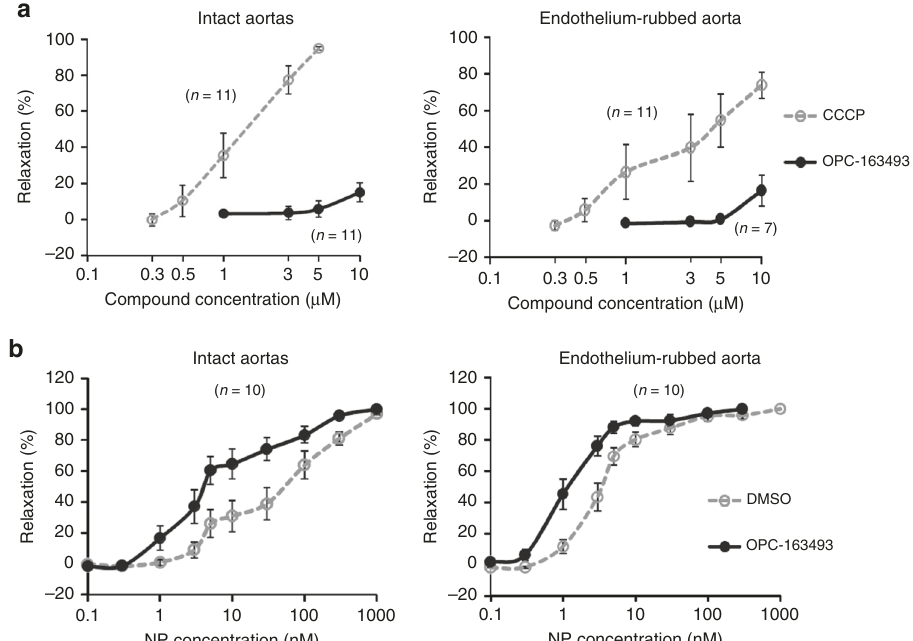
Fig. 9 Effects of OPC-163493 on rat thoracic aortas. Data represent mean ± SE. a Effects of CCCP and OPC-163493 on PE-induced constriction of rat thoracic aortas. Test compounds were added 10 min after PE addition and their relaxation effects were measured for 10 min. Gray open circles and dashed line, CCCP; black circles and line, OPC-163493. b Sensitization of OPC-163493 to NP-induced relaxation of rat aortas. OPC-163493 was pretreated 10 min before PE addition and NP treatment was started 10 min after the PE addition. EC 50 values were estimated by regression analysis (NP concentrations were subjected to Log transformation). Gray open circles and dashed line, DMSO control; black circles and line,